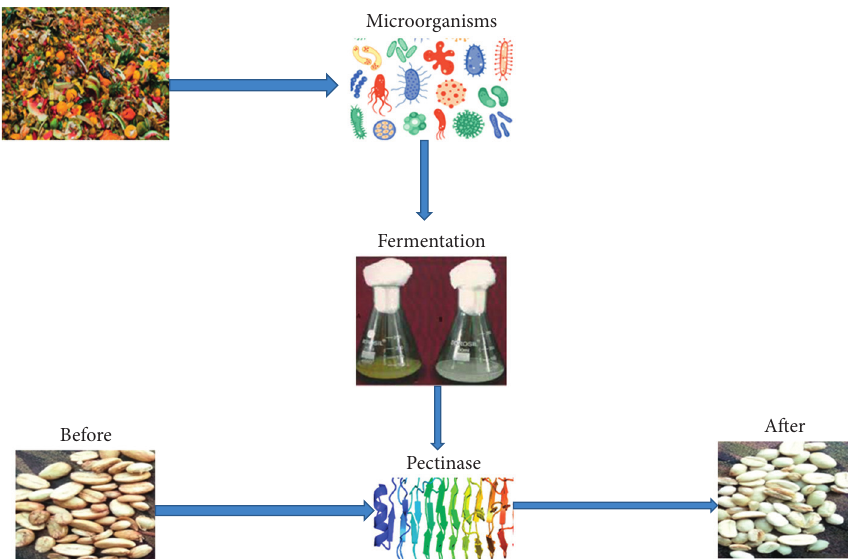
Figure 5: Pectinase for mucilage removal of coffee beans